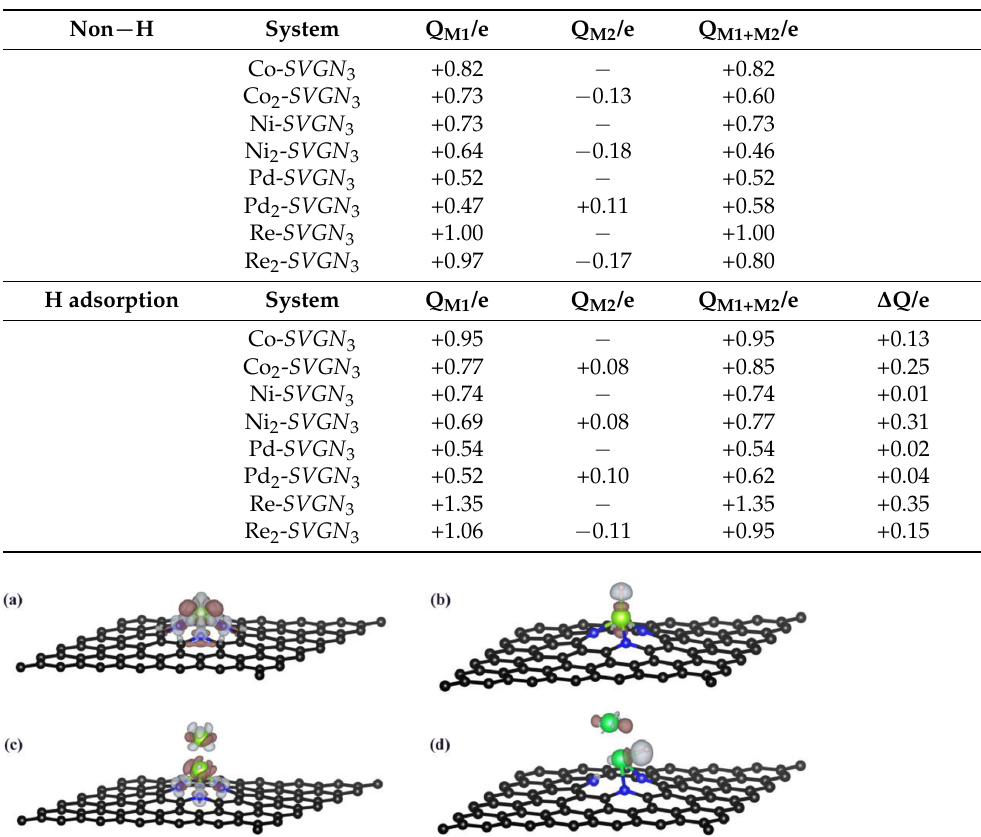
Figure 7. The charge density difference of ( a , c ) Re − SVGN 3 , Re 2 − SVGN 3 without H adsorption and ( b , d ) Re − SVGN 3 , Re 2 − SVGN 3 with H adsorption. (Color code: C, black; N, blue; Re, green; H, white; positive charge density, gray; negative charge density, dark red.).